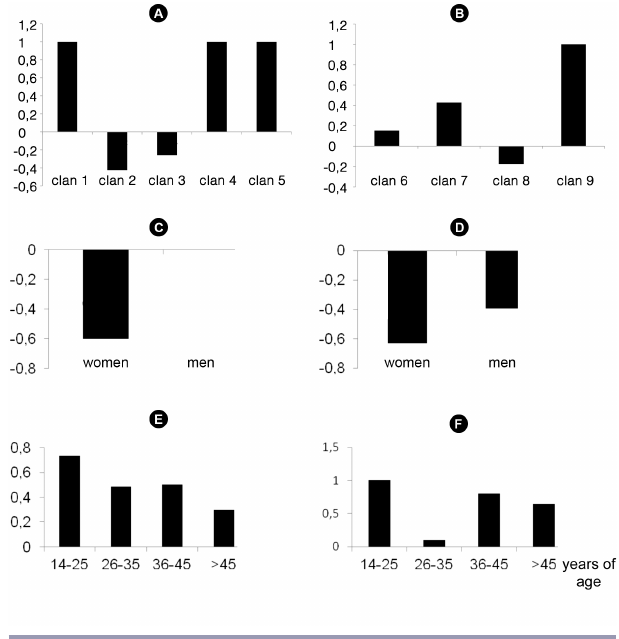
Fig. 4. Graphic representation of external-internal (E-I) indexes isolated village. (B, D, F) More isolated village. E-I